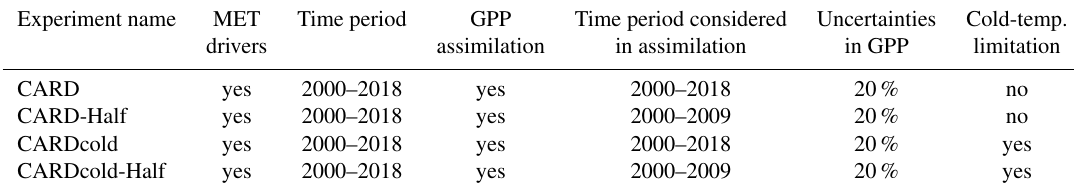
Table 1. Summary of CARDAMOM modeling experiments to determine sensitivity of seasonal and interannual spring GPP variability to cold-temperature limitation (CARD vs. CARDcold) and the ability to perform outside the training window